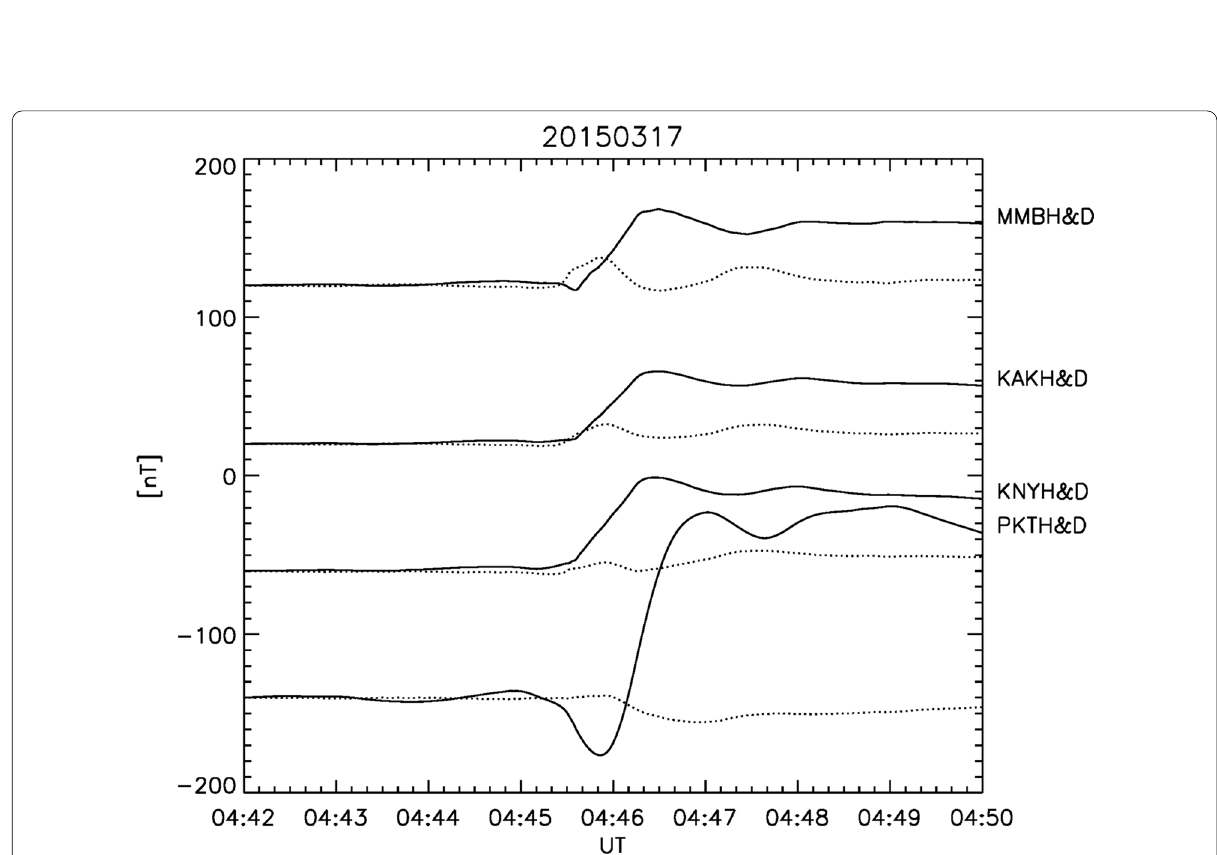
Fig. 5 SCs recorded at middle latitudes; Memambetsu (MMB, 35.72º GML), Kakioka (KAK, 27.76º GML) and Kanoya (KNY, 22.30º GML), Japan in the afternoon sector (14 MLT), and at the geomagnetic equator; Phuket, Thailand (PKT, -1.53º GML) in the pre-noon sector (11 MLT). The H- and D-components are plotted with the solid and dotted curves, respectively. The SC is composed of the DL at middle latitudes, while the PI and MI are superposed on the DL at the